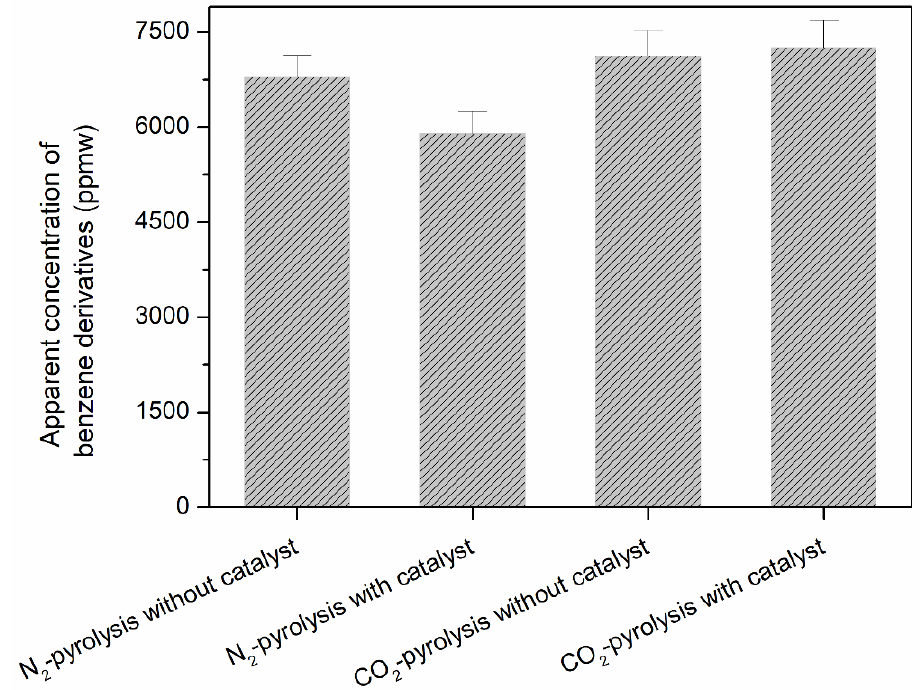
Figure 3. Comparison of total concentrations of benzene derivatives produced via the pyrolysis of the herbal medicine waste in four different conditions. Apparent concentration was determined by GC-MS using phenol as an internal standard. Mean values of replicates ( n = 3) are reported with standard deviations given as error bars.